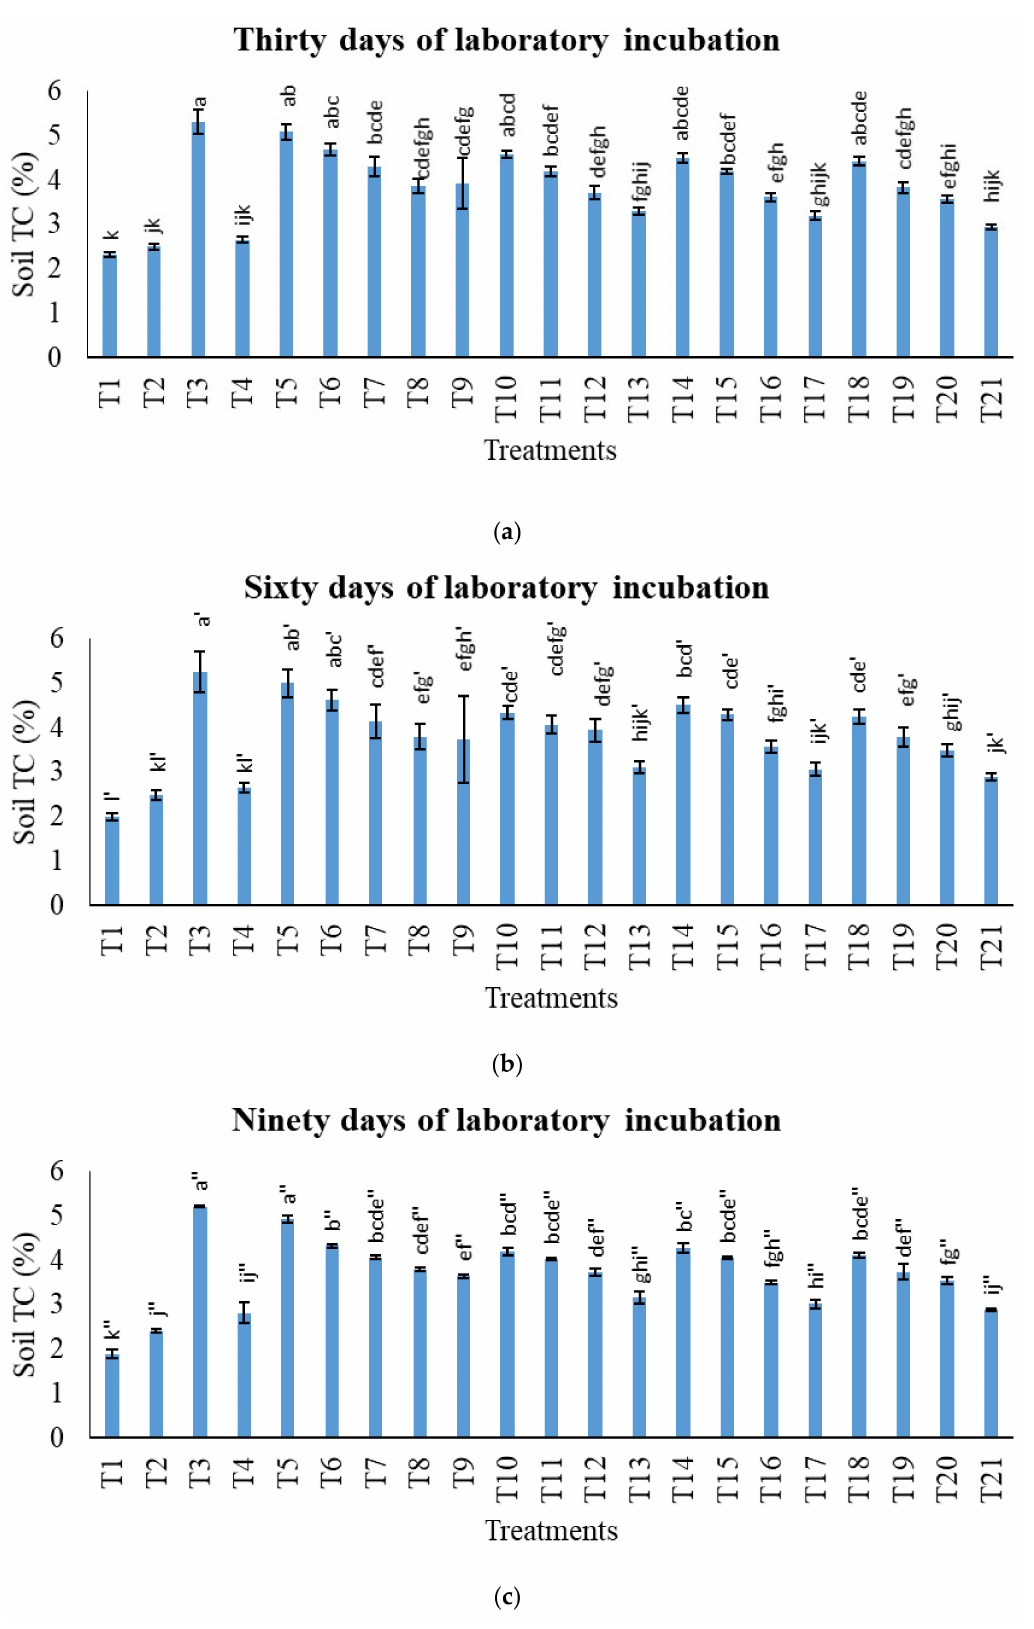
Figure 6. Effects of treatments on soil total carbon over ( a ) thirty; ( b ) sixty; and ( c ) ninety days after incubation. T1: soil control, T2: conventional practice, T3: muriate of potash + 100% charcoal + 100% sago bark ash, T4: muriate of potash + 100% sago bark ash, T5: muriate of potash + 100% charcoal, T6: muriate of potash + 80% charcoal + 80% sago bark ash,